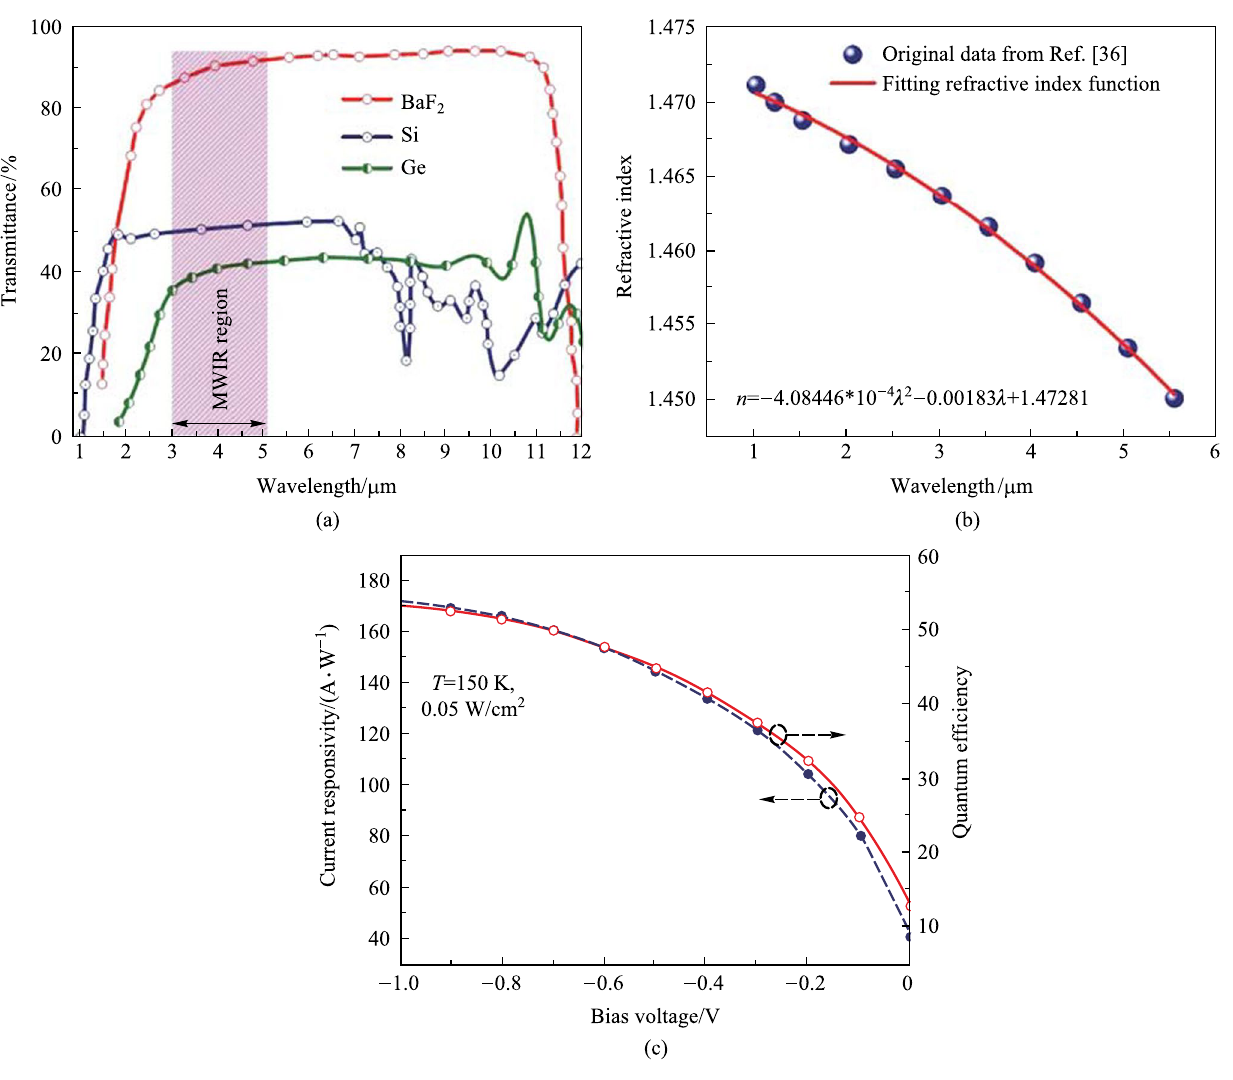
Fig. 7 δ-DCGB nBn-PD device with BaF 2 as the anti-reflection coating material at 150 K. a Transmittance of BaF 2 and current infrared anti-reflection coating materials. b Polynomial fitting of the refractive index of BaF 2 . c Current responsivity and quantum efficiency versus the applied bias